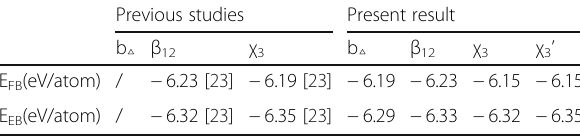
Table 1 Our calculated lattice constants a , b , and γ for the buckled triangular, β 12 and χ 3 boron sheets. Previous results are also listed for comparison Previous studies